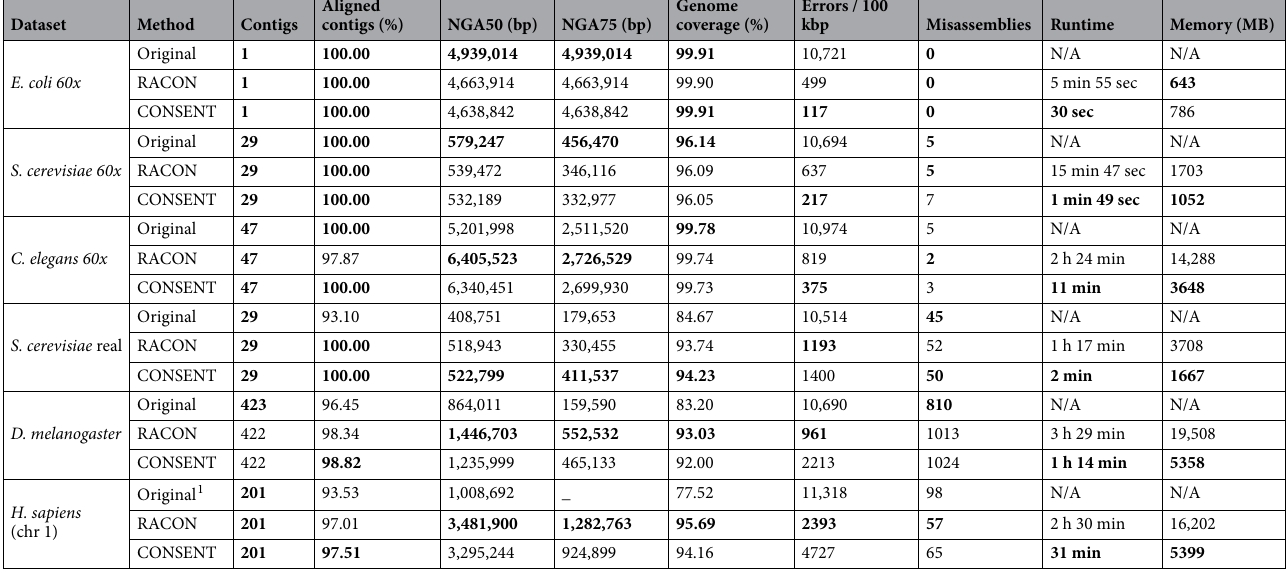
Table 4. Statistics of the assemblies, before and after polishing with RACON and CONSENT. The missing contig for the CONSENT and RACON polishings on the D. melanogaster dataset is 428 bp long, and could not be polished, due to the window size of the two methods being larger (500). Best results for each metric is highlighted in bold. 1 For the assembly of the original reads on the H. sapiens (chr 1) dataset, QUAST-LG did not provide a metric for the NGA75.